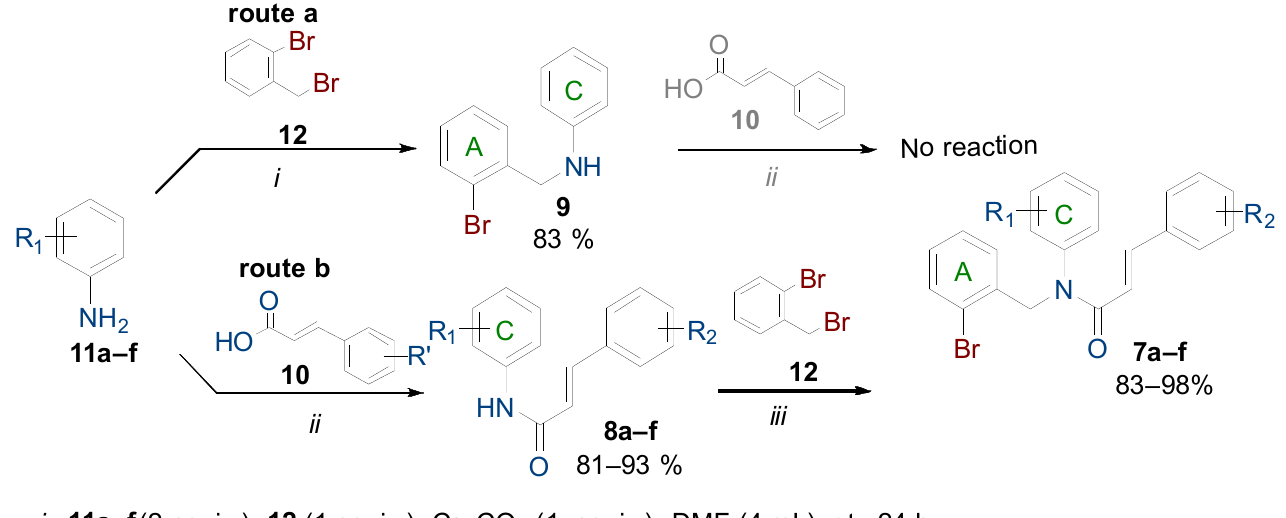
Scheme 2. Study of the optimal synthetic strategy for the synthesis of N ‐ aryl ‐ N ‐ (2 ‐ bromobenzyl) cinnamamides 7a – f from anilines 11a – f